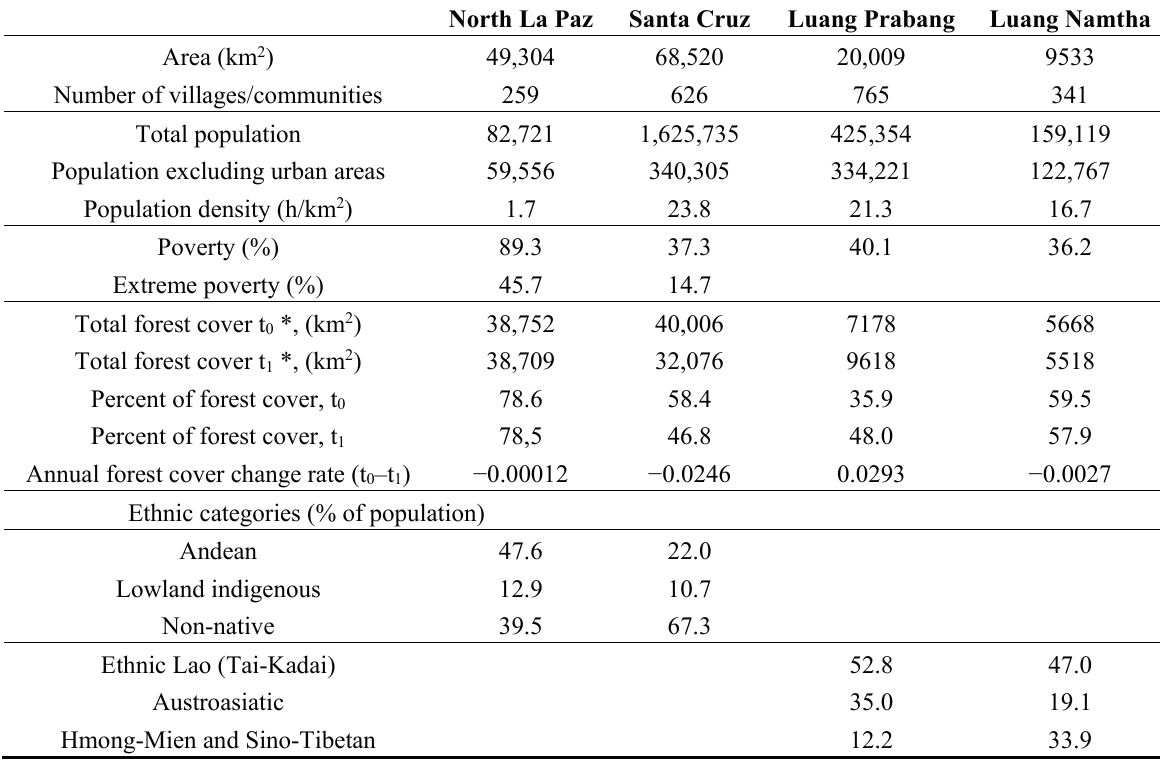
Table 1. Main characteristics of the study